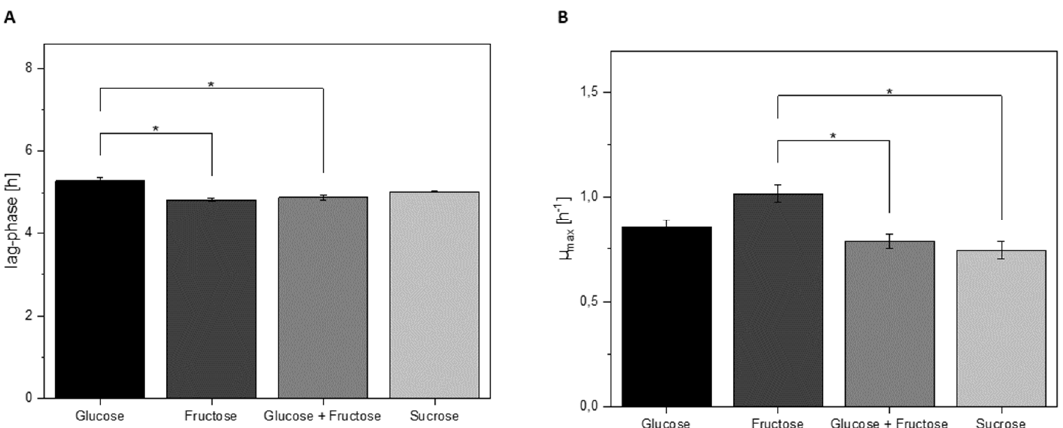
Figure 7. Lag phase ( A ) and maximum growth rates (µ max ) ( B ) of L. hordei TMW 1.1822 in glucose, fructose, sucrose and a combination of glucose and fructose. * = p <